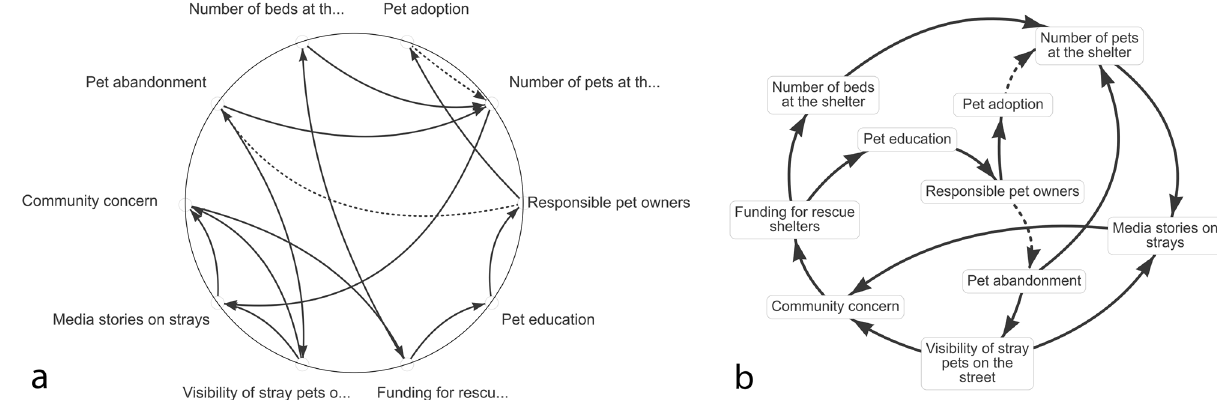
Fig. 5 Connection circle and diagram view in the STICKE user interface. a The connection circle view as it appears in STICKE following user input of factors deemed important drivers of the problem, and causal relationships between those factors. b The diagram view as it appears in STICKE following automated untangling of the connection circle in